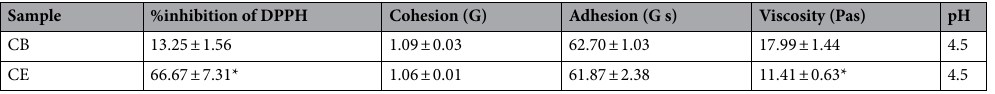
Table 3. Physical characteristics and biological properties of the extract-loaded emulsion (CE) and emulsion base (CB). CB is the emulsion base; CE is the extract-loaded emulsion. The results were expressed in Mean ± SD. *indicates statistical differences between tested parameters of CB and CE.